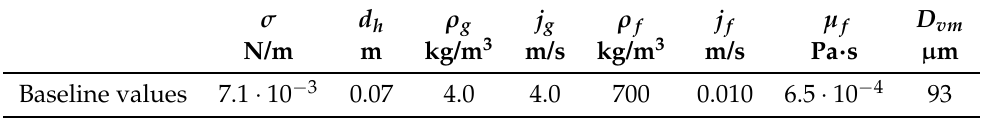
Table 3. Chosen baseline values for the parameters in Equation (17), and the resulting value for D vm .